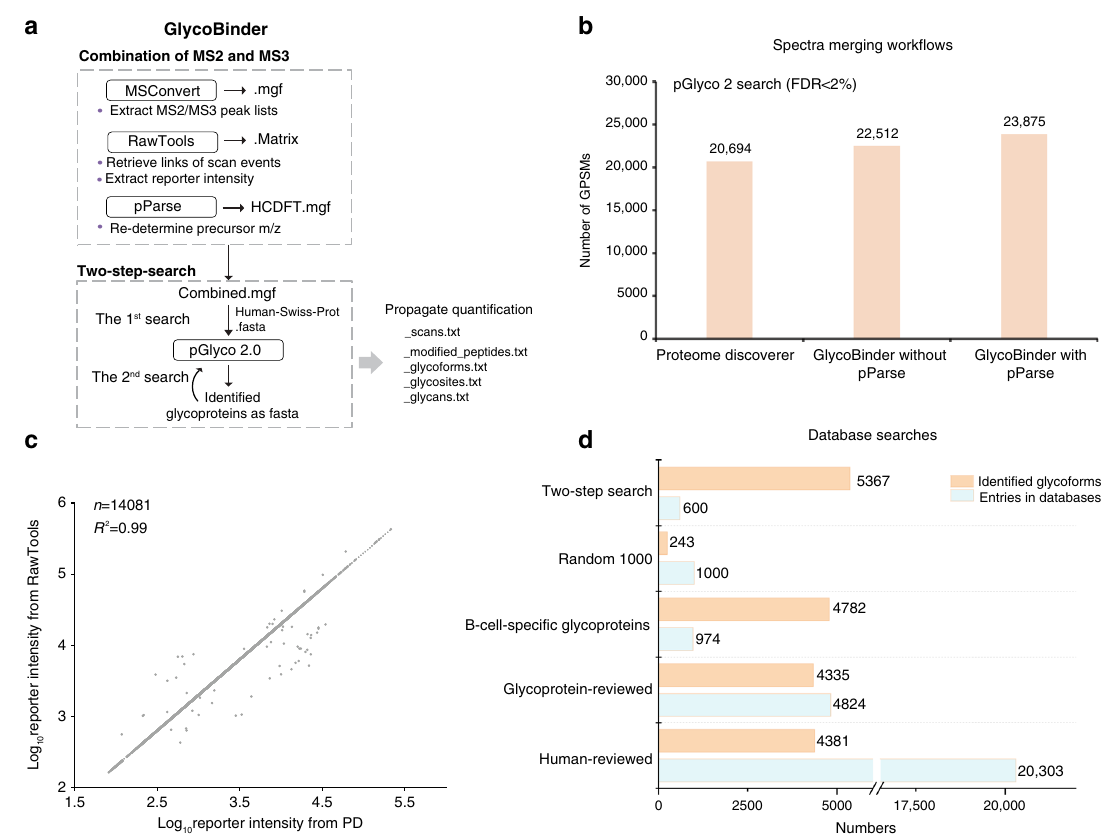
Fig. 3 GlycoBinder enables streamlined MS3 data handling for advanced intact glycopeptide identi fi cation and accurate multiplexed quanti fi cation. a The schematic work fl ow of GlycoBinder. b Different spectra-merging work fl ows produced different GPSM identi fi cation rates. TMT-labeled N - glycopeptides derived from DG75 cells were analyzed by Glyco-SPS-MS3 (48 raw fi les). All combined mgf fi les were searched using pGlyco 2 against a human database under 2% FDR. c Correlation of reporter ion intensities extracted by RawTools and PD. Each circle represents the extracted reporter ion intensity from a scan. A total of 14,081 reporter ions were compared. d Comparison of the two-step search with single searches using various databases (see main text). Sizes of the databases (light blue) and the resulting numbers of identi fi ed glycoforms (light brown) are shown. Source data are provided as a Source Data fi